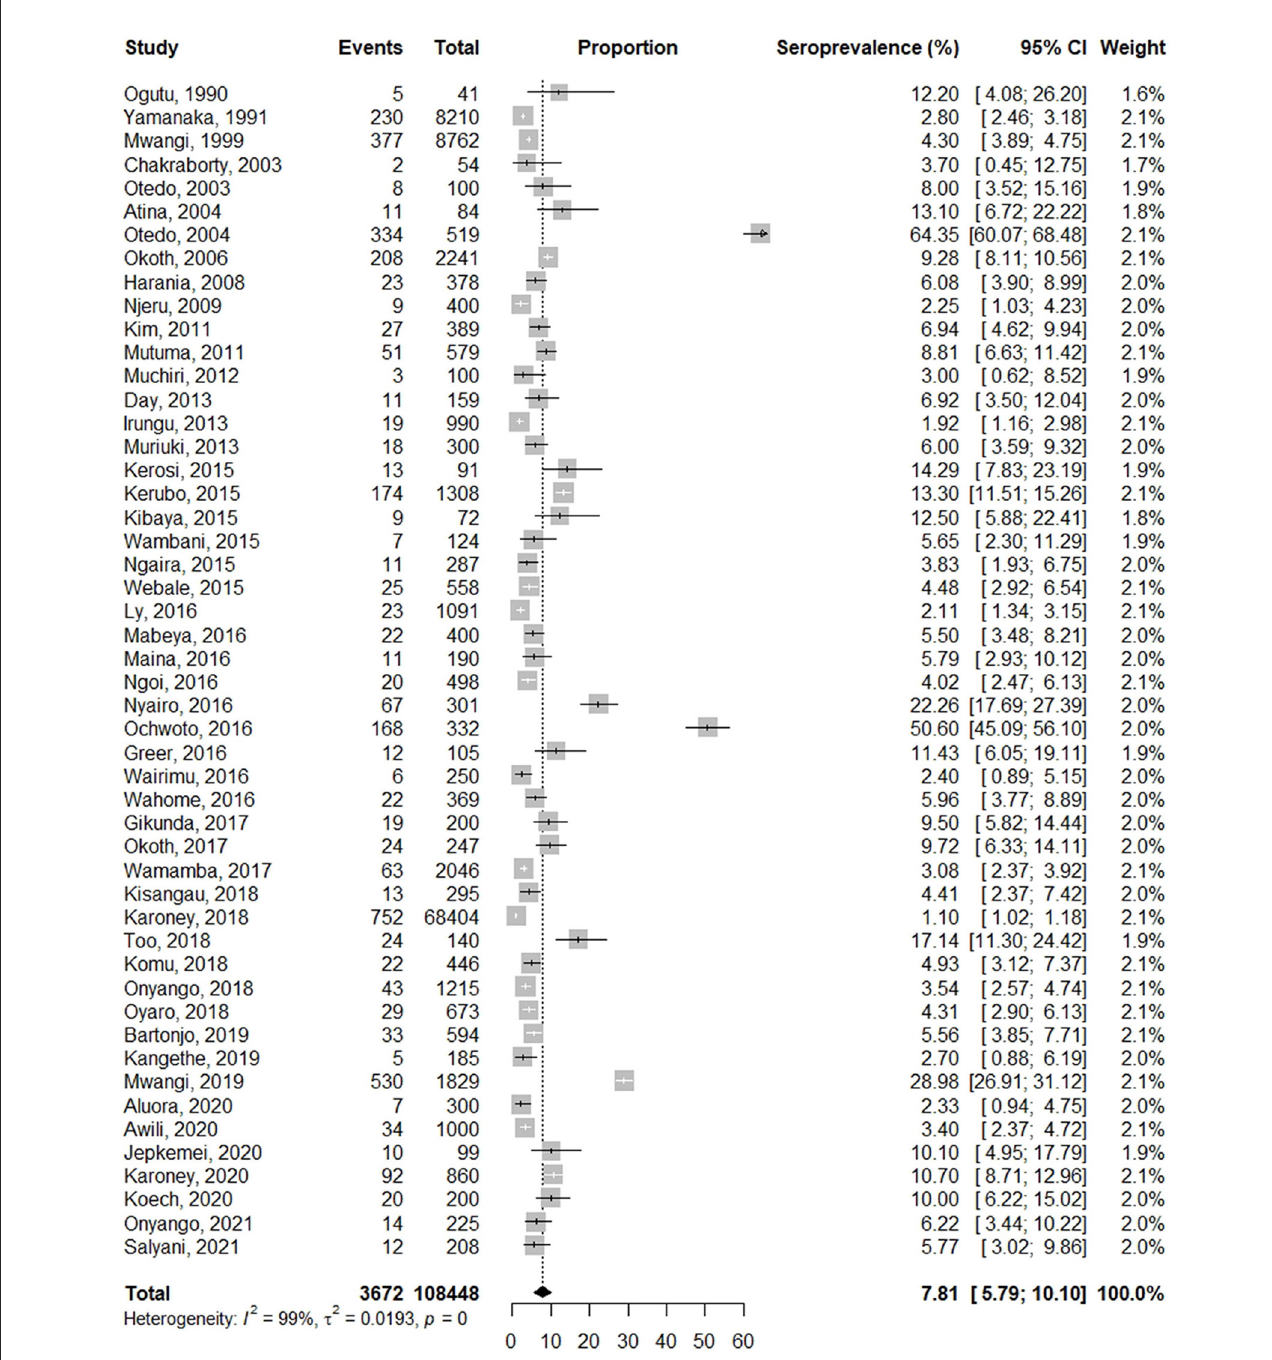
FIGURE2 Analysis of the pooled prevalence estimate of HBV in Kenya.